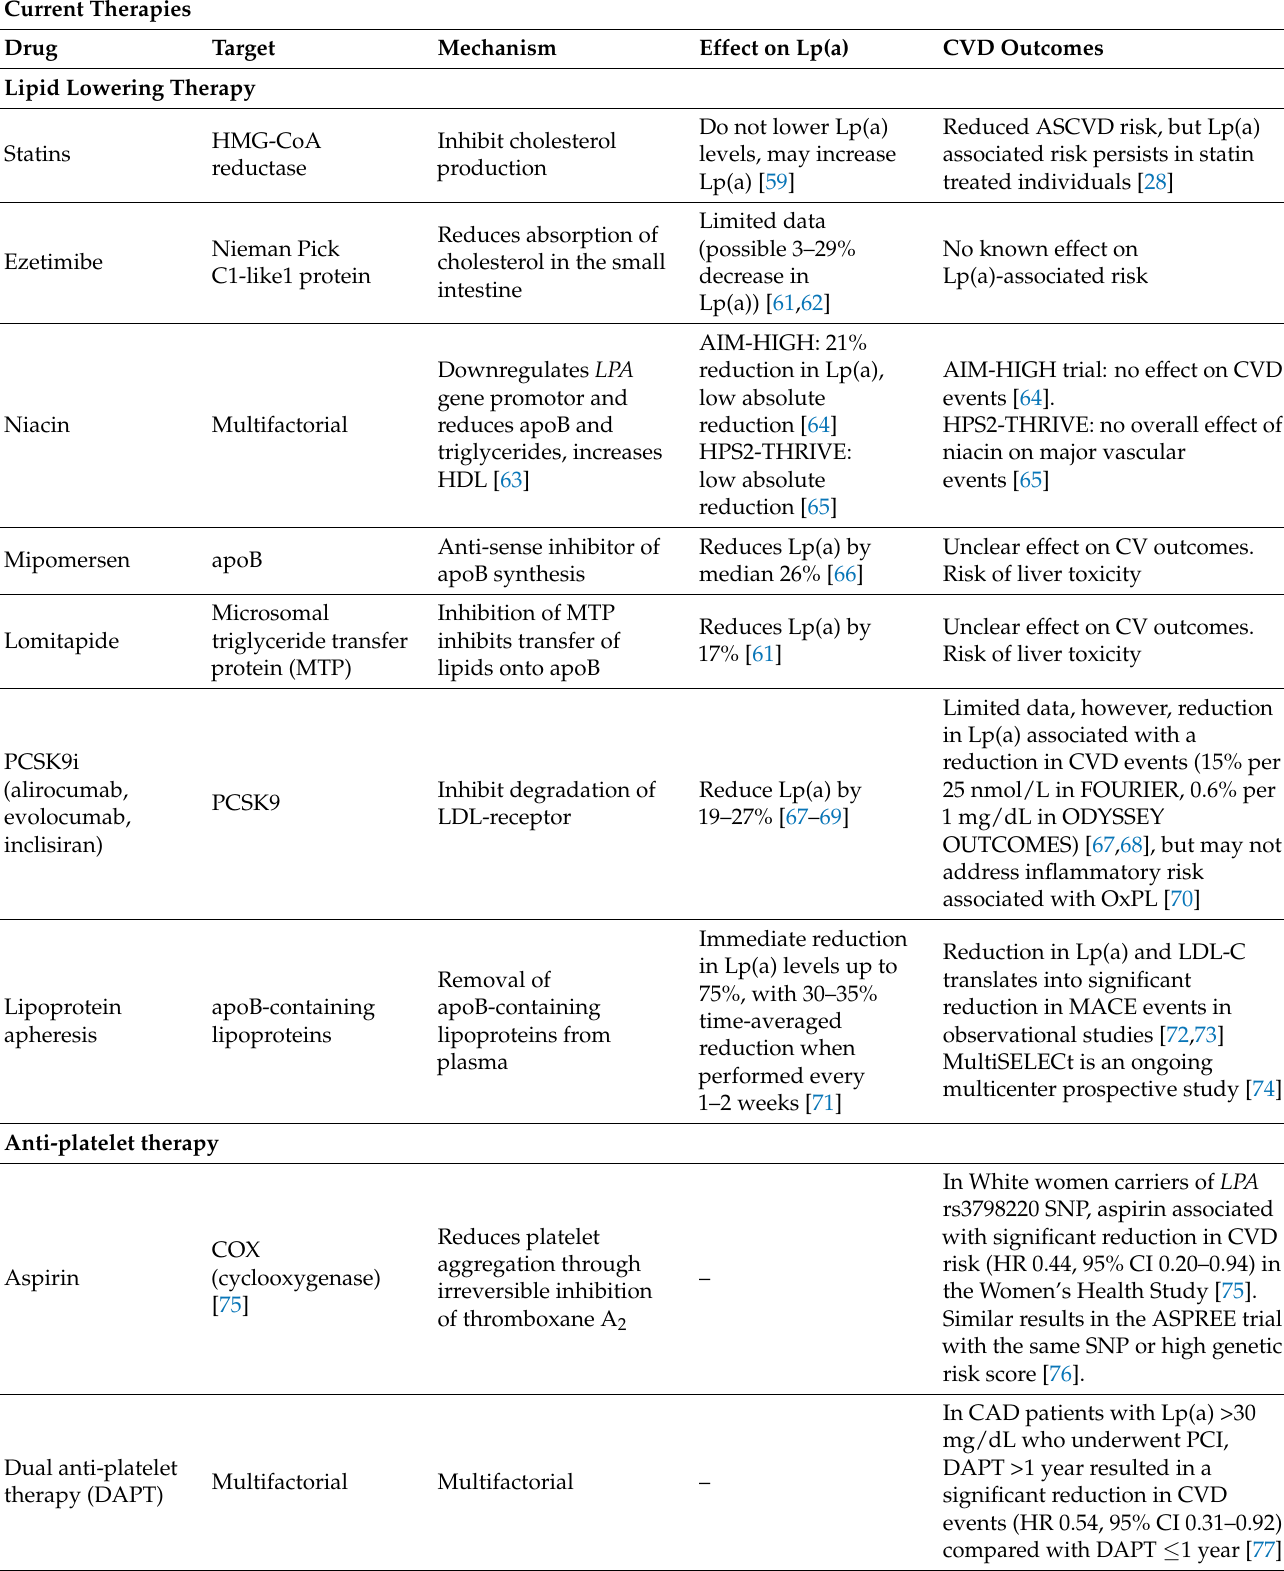
Table 3. Current and emerging therapies for